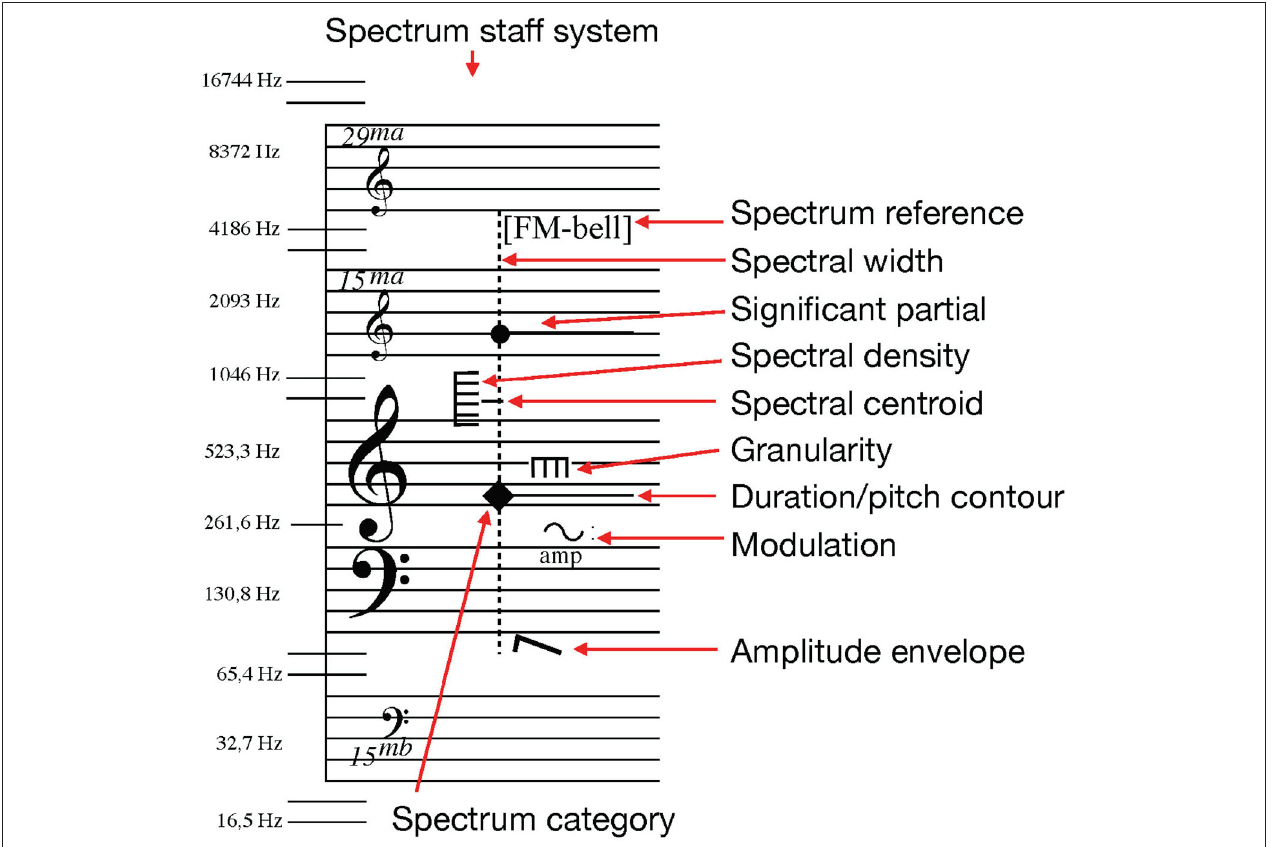
FIGURE 1 | An overview of the basic notation features of the sound notation system, used to describe one dystonic (inharmonic) sound object with the partial with the highest amplitude at F4, and a secondary high-amplitude partial at G6. There is significant spectral information, spectral width, between 80 Hz and 4.7 kHz, and it is a nearly maximum density spectrum as indicated by the vertical comb with six teeth. This image has been previously published ( Sköld,